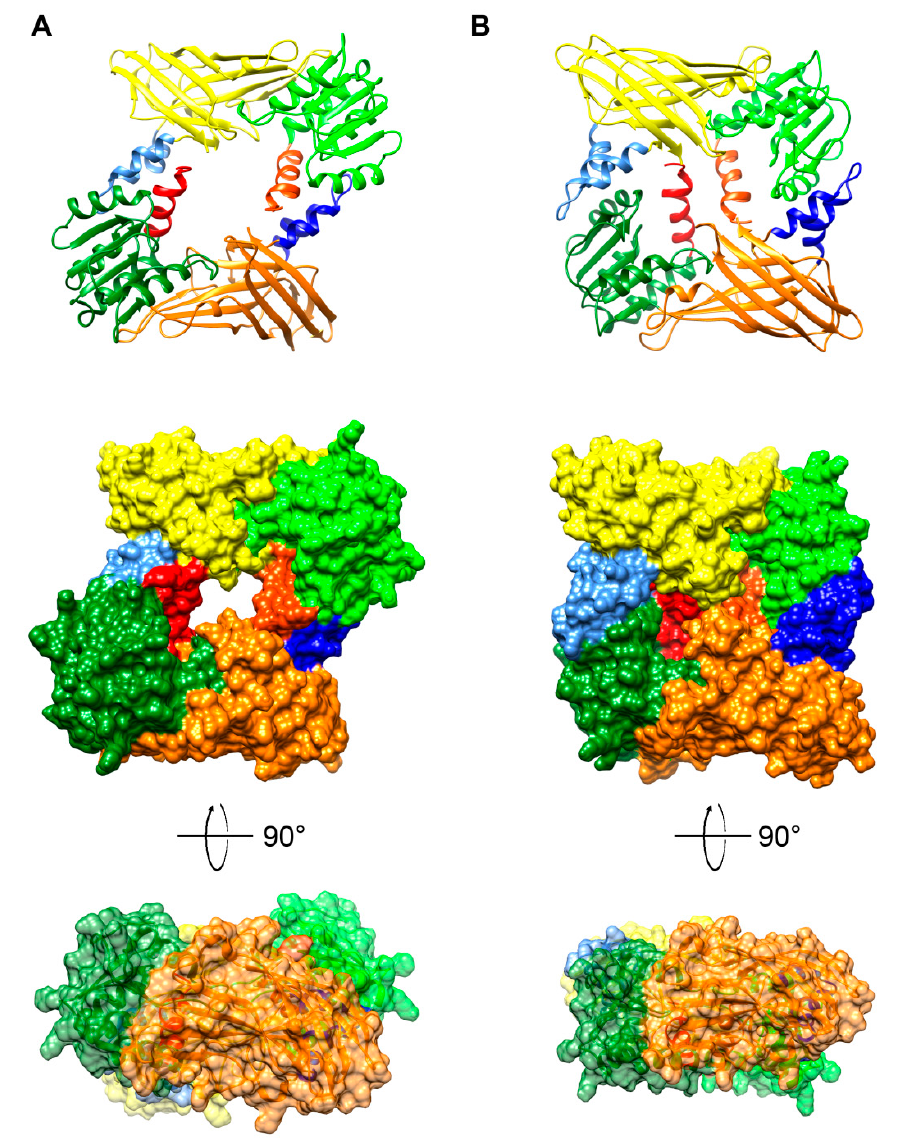
Figure 9. P. lividus PRMT1 dimer structure models obtained by ClusPro [89]. The colour coding is red / orange red for the N-terminal domains, green / light green for the SAM binding domains, orange / yellow for the β barrel structures, and blue / light blue for the dimerization arm. ( A ) the ring-like model similar to the model described in Zhang and Cheng [85]; ( B ) the best ranked compact model.